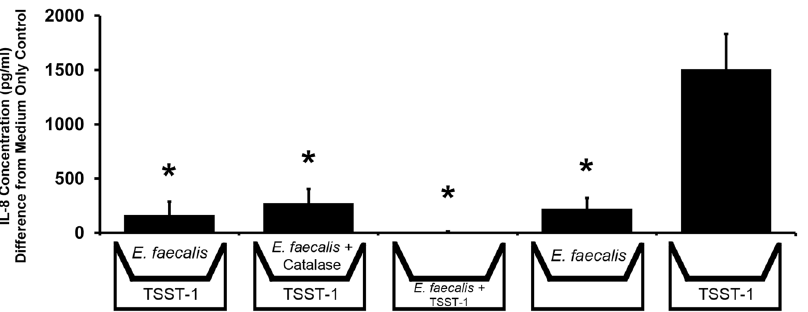
Figure 3. E.faecalis MN1 secretes a factor responsible for inhibition of IL-8 production by HVECs in response to TSST-1. Transwell permeable supports (0.4 m m pore size) were used to determine the ability of E. faecalis MN1 secreted factors to inhibit TSST-1-induced IL-8 production by HVECs. HVECs were grown to confluency in the bottom wells and transwell permeable supports were added on the day of experimentation. E. faecalis MN1 (2 6 10 7 CFU) was added to either the transwell (to assess secreted factors) or the bottom well (as a positive control) in the presence or absence of TSST-1 (100 m g/ml) and incubated for 6 h. In one condition, catalase enzyme (100 m g/ml) was added to break down hydrogen peroxide produced by the lactobacilli. Cell culture supernates were collected and analyzed by ELISA for IL-8 production. These results contain data averaged from three separate experiments, with 6 total replicates in each experimental condition. *All conditions with E. faecalis MN1 present demonstrated significantly lower IL-8 levels compared to the TSST-1 only control by individual Student’s t tests (p , 0.01).